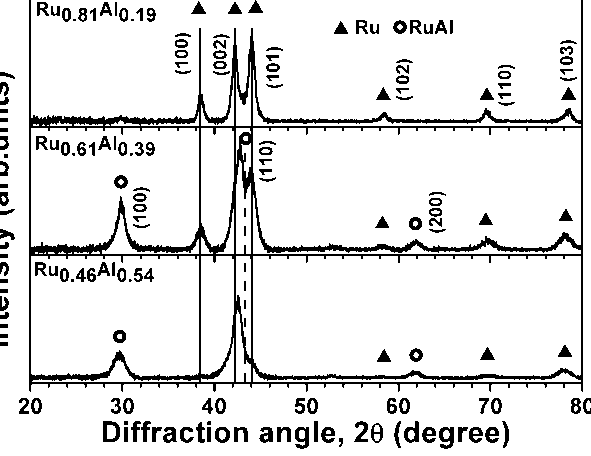
Figure 8. XRD patterns of the as-deposited Ru–Al thin films prepared on Inconel 617 substrates with a Ru interlayer.